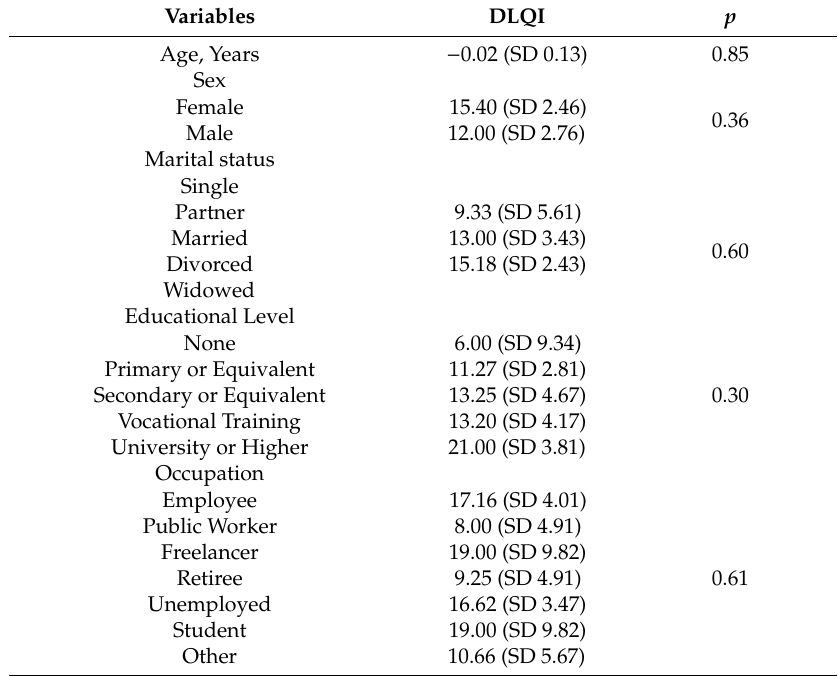
Table 2. Univariate analysis of potentially factors associated with quality of life in HS